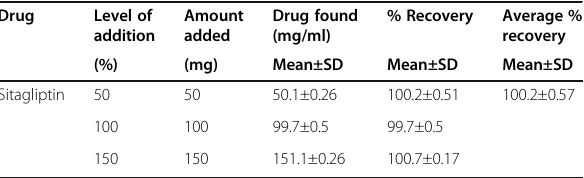
Table 5 Accuracy of the developed method for sitagliptin ( n =3)